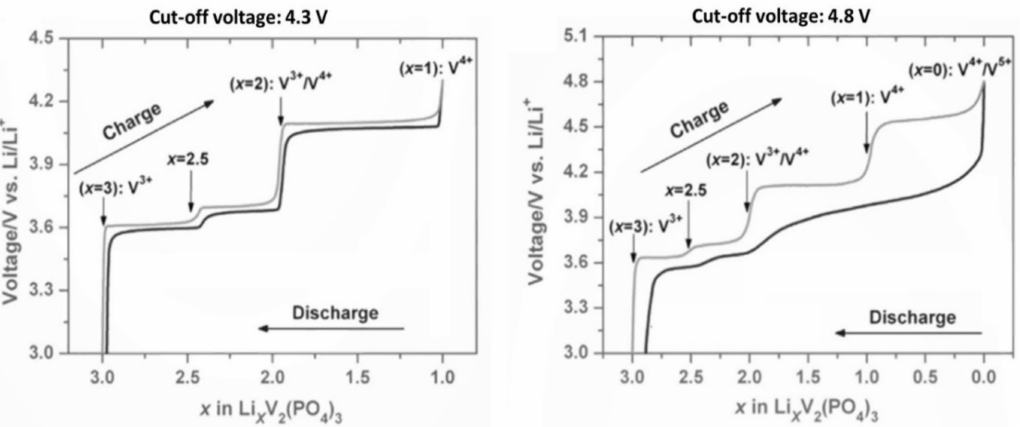
Figure 4. Electrochemical signature of Li 3 V 2 (PO 4 ) 3 cycled between (left) 3.0 and 4.3 V vs. Li + /Li or between (right) 3.0 and 4.8 V vs. Li + /Li adapted from ref. [29]. Reproduced with permission from Rui et al., Journal of Power Sources; published by Elsevier,